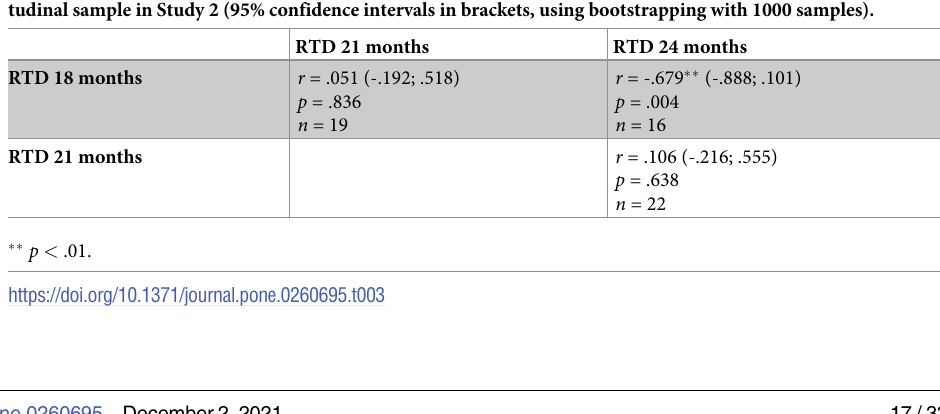
Exploratory analysis: Associations between the ECITT and other IC tasks. Participants